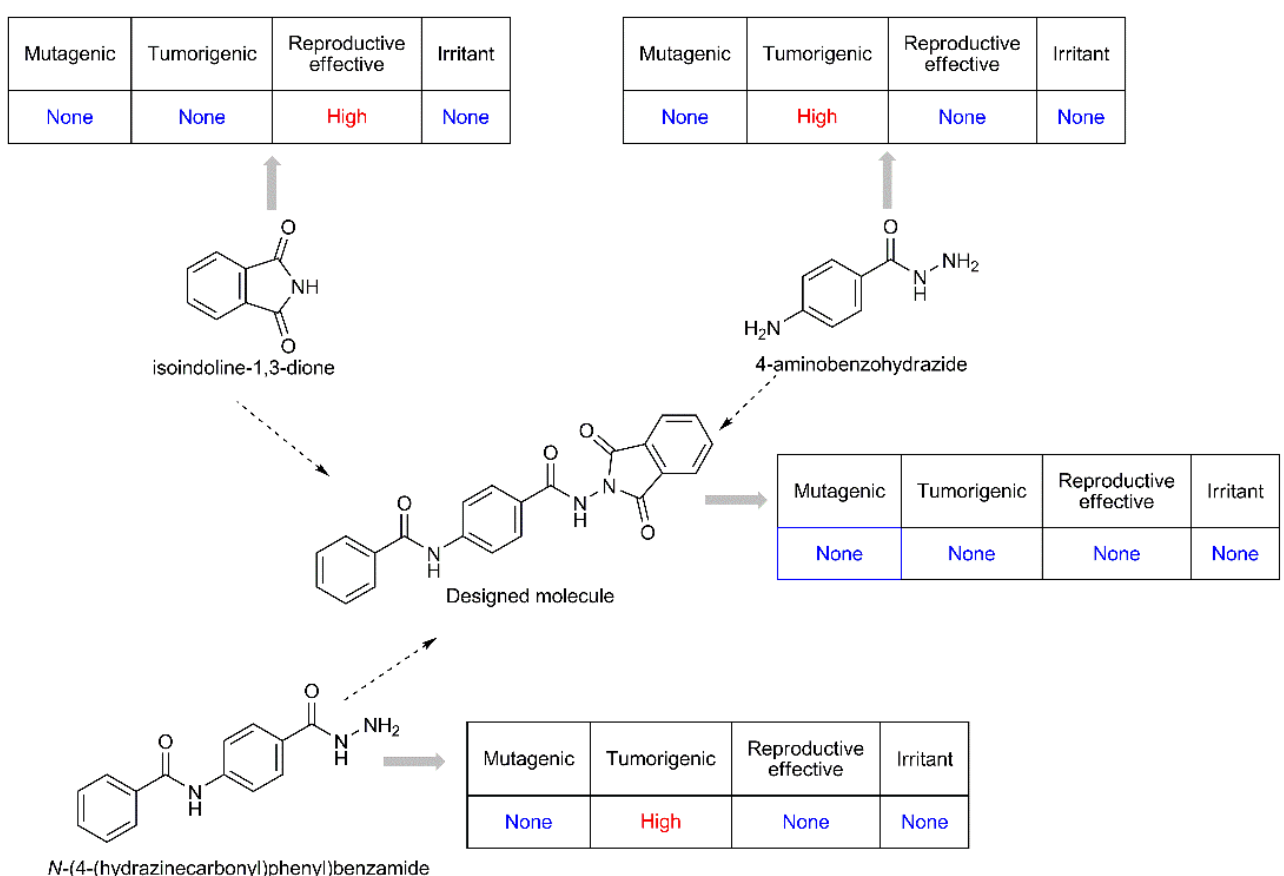
Figure 2. The toxicity profiles of designed molecules.